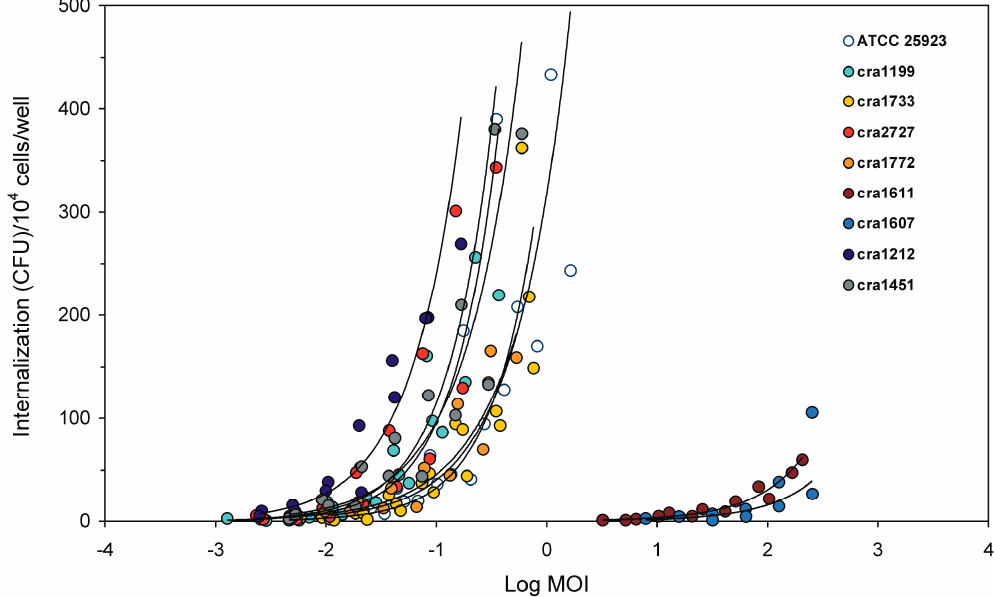
Figure 4. Correlation of CFU vs. MOI on semi-logarithmic scale. The regression curves of internalised CFU as a function of the 10-base logarithm of MOI are shown for all S. aureus strains.